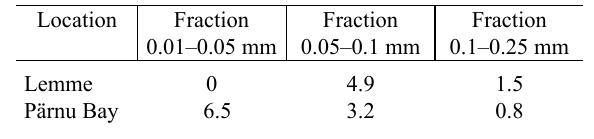
Table 9. Zircon percentage in heavy minerals of the Lemme samples and the surrounding nearshore sediments of Pärnu Bay (Lutt & Popova 1993) (counting results of the optical microscopy analysis) Location Fraction Lemme Pärnu Bay